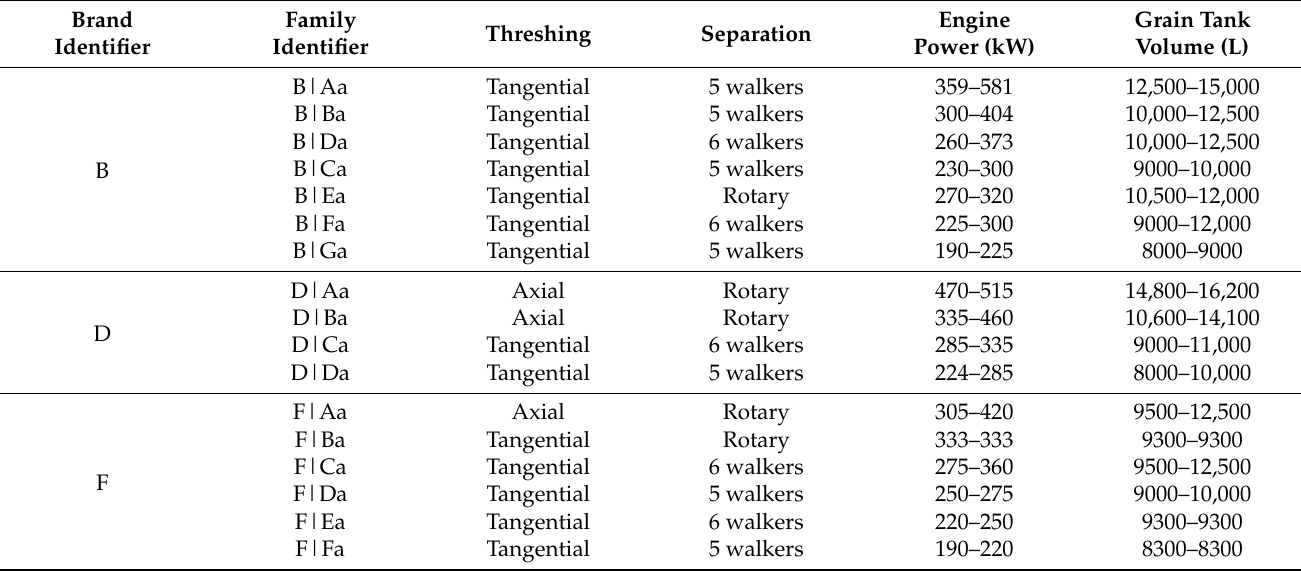
Table 3. Family model